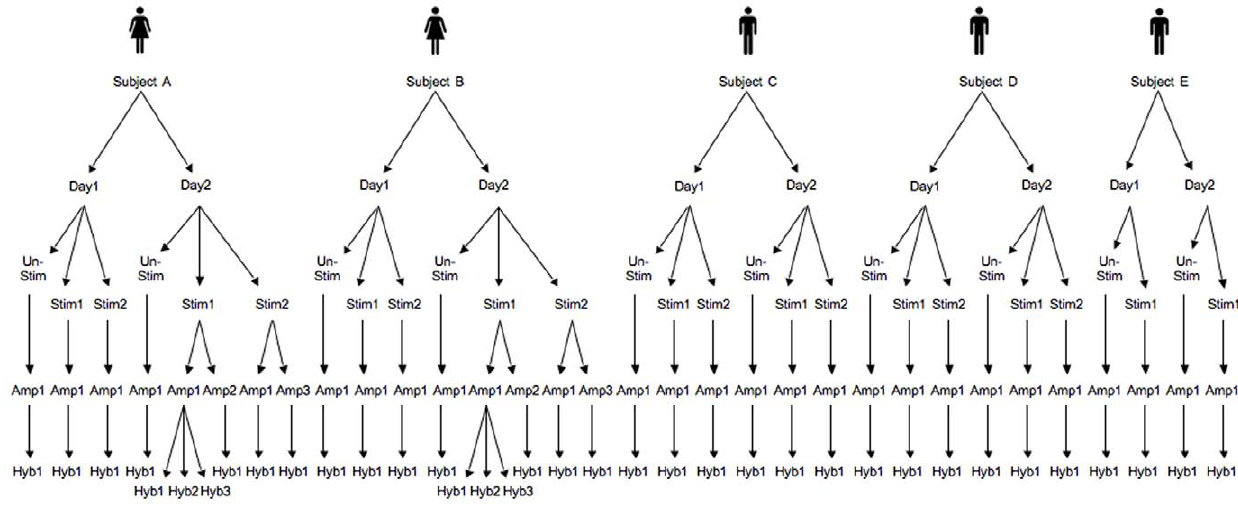
Figure 1. Experimental design showing samples used to compare variability. Samples: Subject A–E, Day 1 and 2, LPS-stimulated sample (Stim) 1 and 2, amplification run (Amp) 1–3, and hybridisation (Hyb) 1–3. For each subject on each day there was also an unstimulated (Unstim) sample at 0 hours.